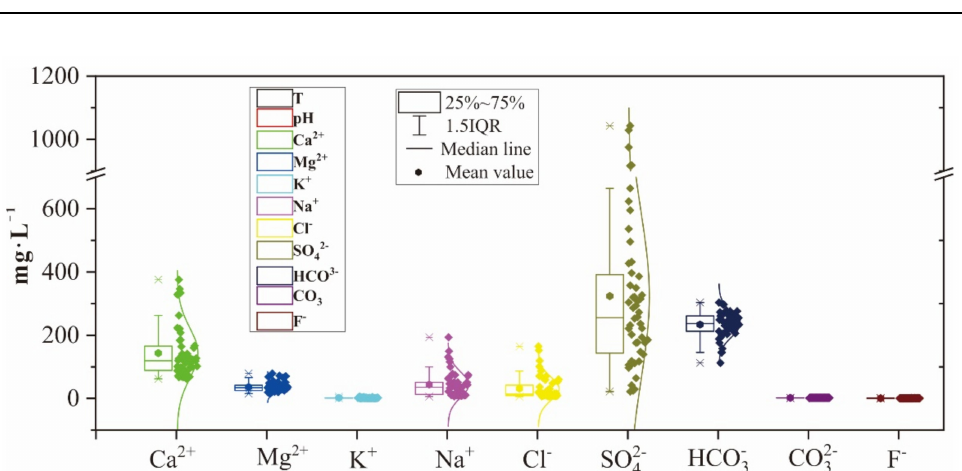
Figure 2. Box chart of ionic concentration in karst groundwater of Niangziguan spring